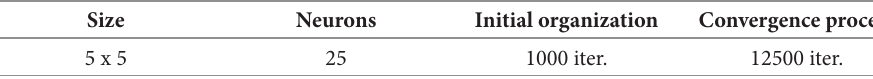
Table 1. Network and learning parameters Size